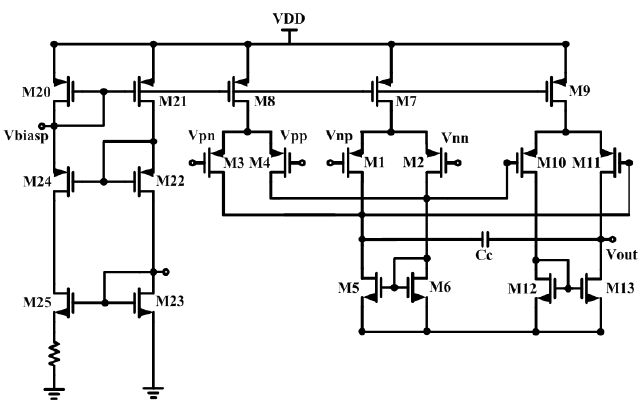
Figure 5. The proposed simplified DDA.